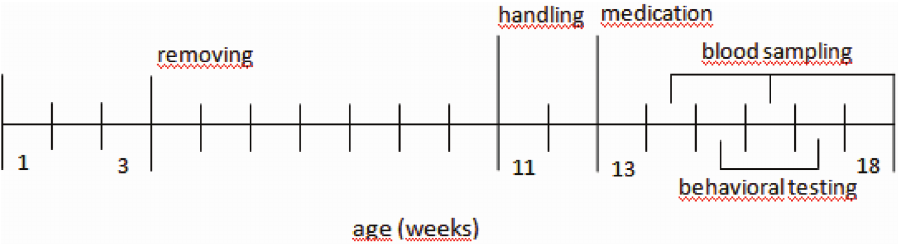
Figure 1 - Timeframe of experimental setup. The male Wistar pups were removed from their mothers at PD 21, housed together, and received ground pellets at this time. At week 11 and 12, the rats were weighed twice per week and were habituated to the activity and alcove box. At week 13, the animals were medicated with haloperidol, clozapine, or ziprasidone (n=20 for all groups) or were fed only ground pellets (controls, n=19). At week 12 and 14, blood was sampled. At weeks 15 and 17, activity and anxiety behavior was tested. After 6 weeks of medication, the rats were anesthetized and their blood and brains